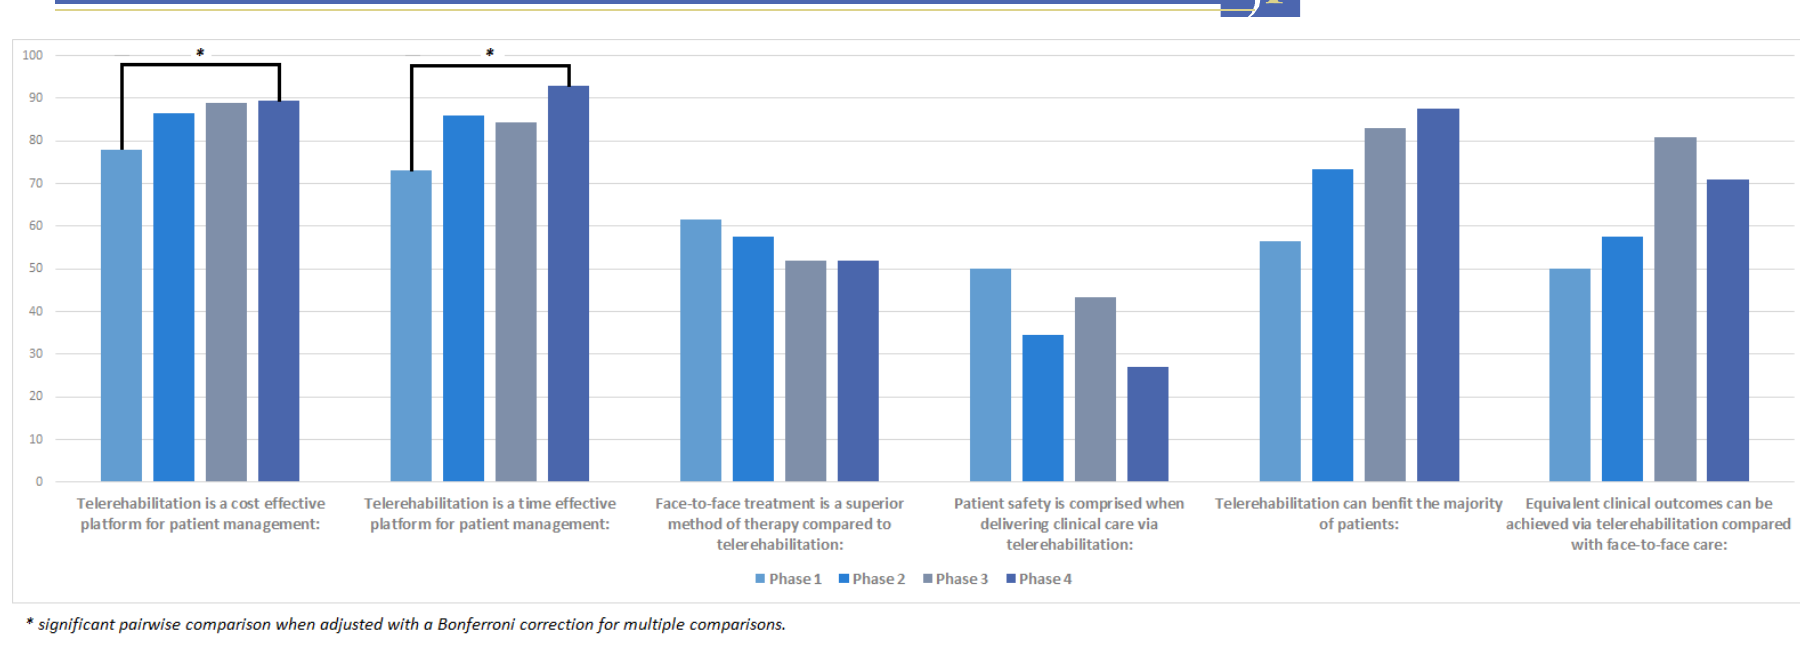
Figure 2. Participants’ change in acceptance towards telerehabilitation. Table 1. Participants’ Satisfaction towards Telerehabilitation Following Three- and Six-months